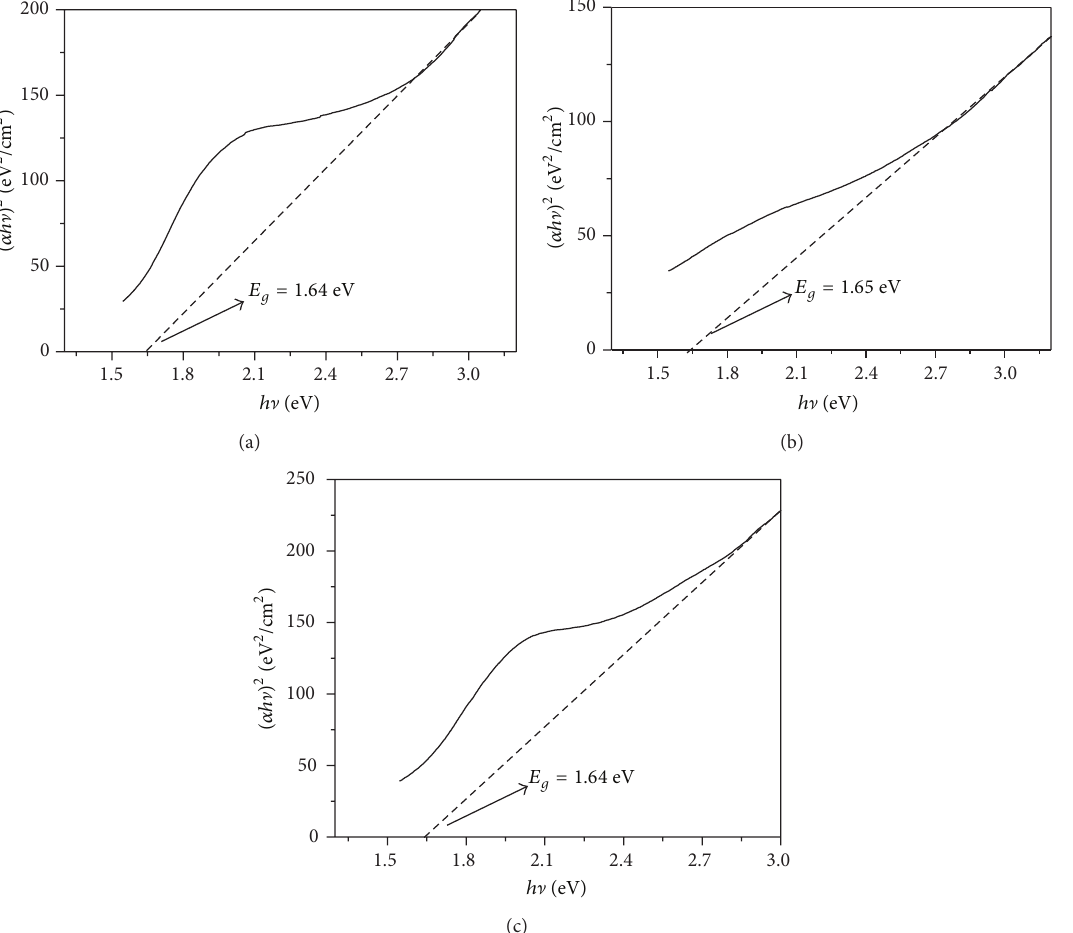
Figure 6: Optical band gap spectrum of CuS nanostructures synthesized at 150 ∘ C (a) without CTAB for 5hrs, (b) with CTAB for 5 hrs, and (c) with CTAB for 24 hrs.